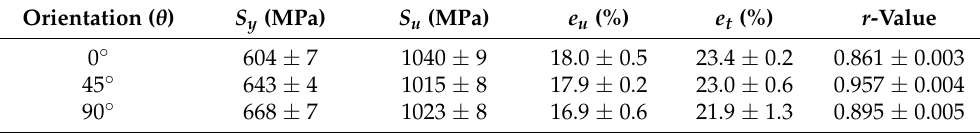
Table 2. The uniaxial tensile properties of the CR980XG3 TM steel.